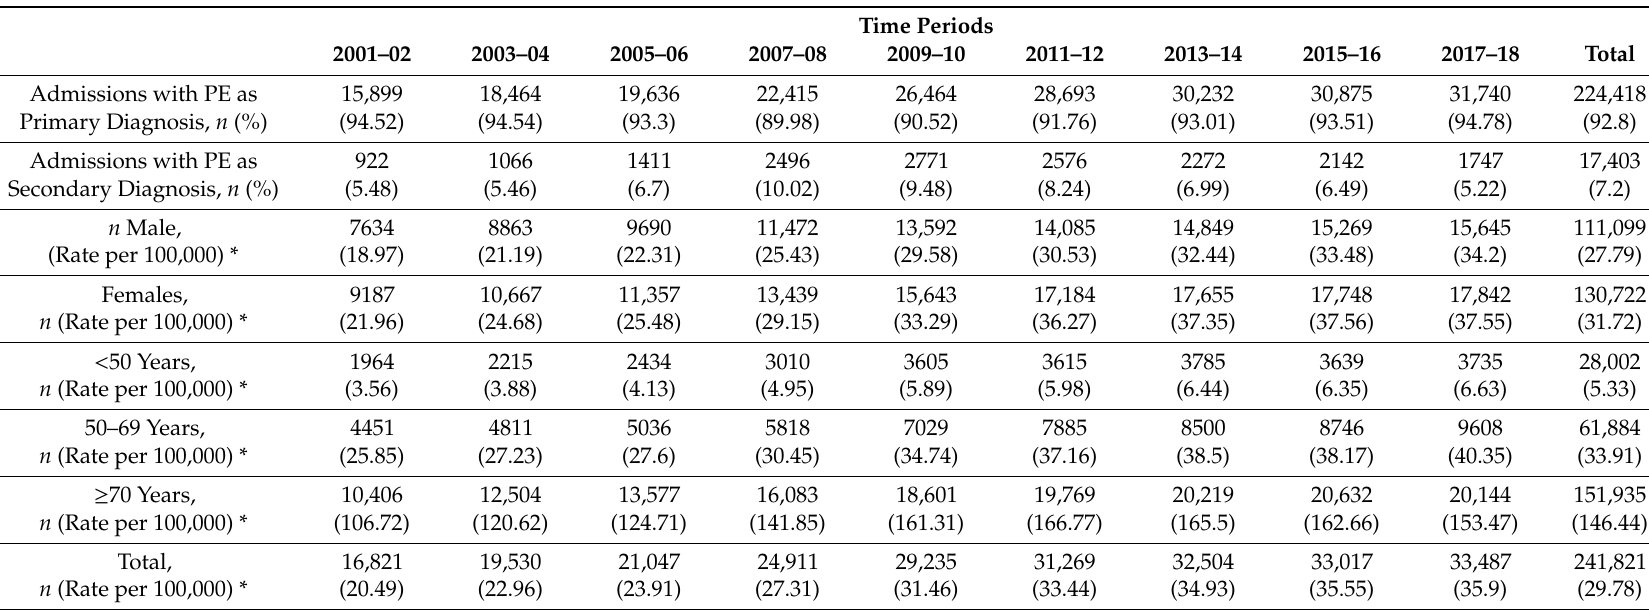
Table 1. Distribution according to diagnosis position and age-sex specific incidence rates for pulmonary embolism (PE) in Spain from 2001 to